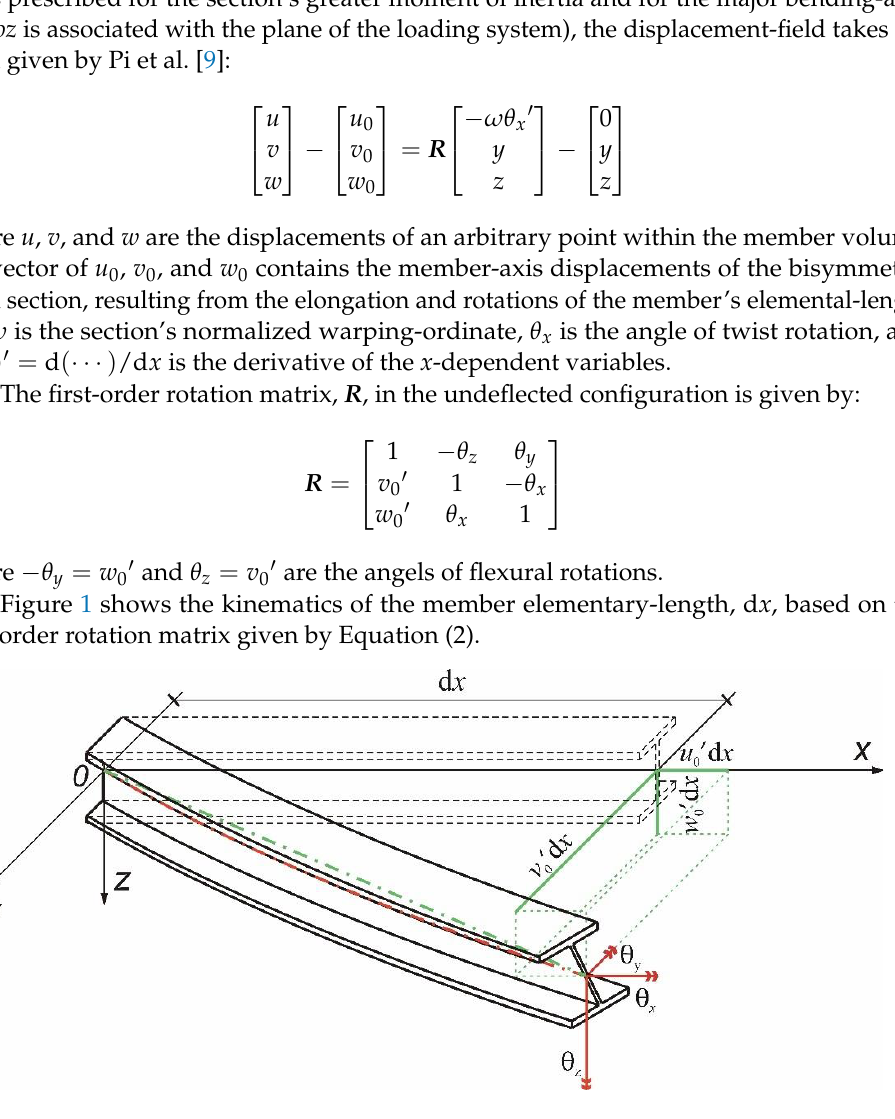
Figure 1. Member’s e lementary-length kinematics in reference to the first-order rotation matrix.